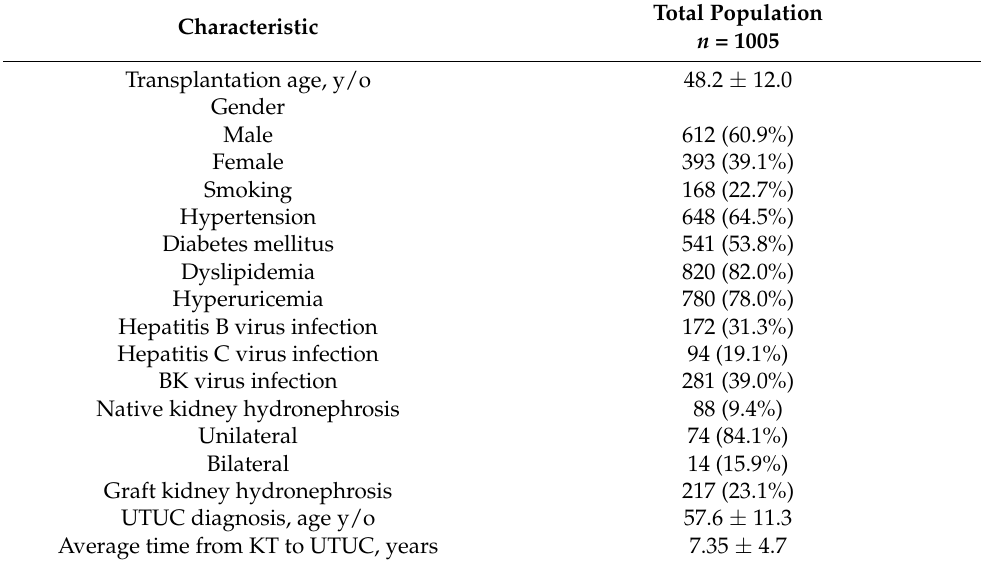
Table 1. Characteristics of KT patients.